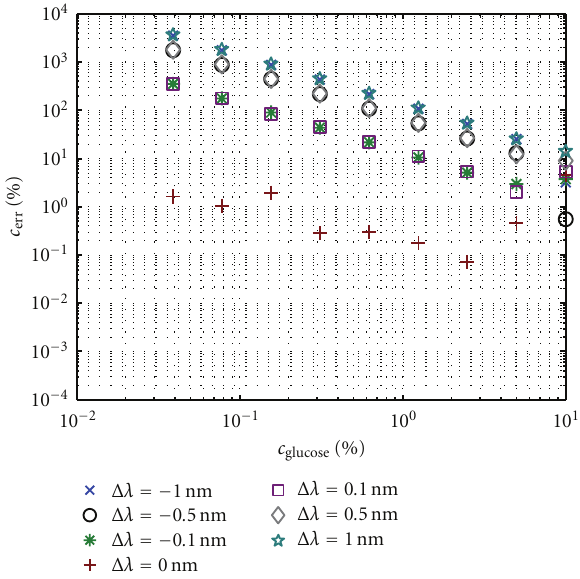
Figure 13: Statistical evaluation using k-fold cross validation for nominal temperature T = 25 ◦ C, showing the e ff ect of wavelength